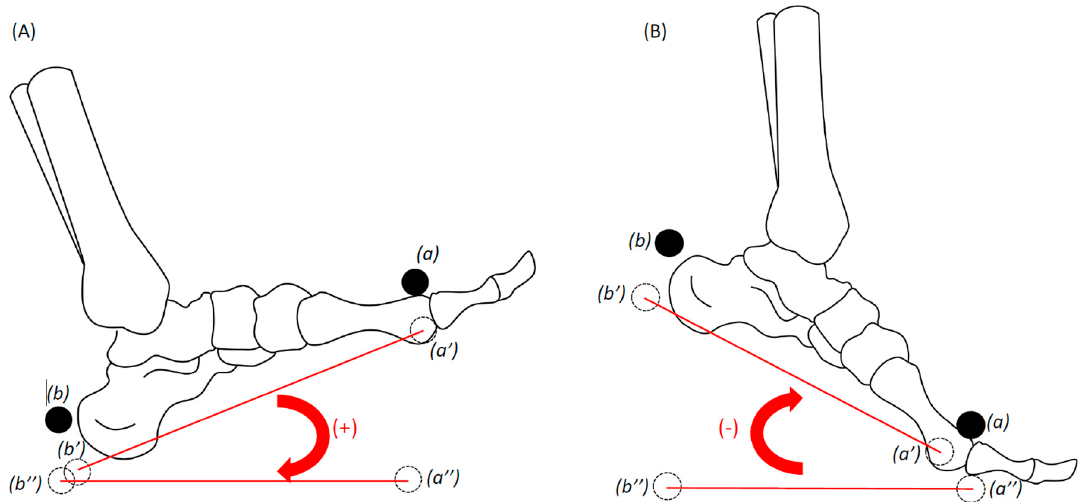
Figure 3. Foot angle is defined as the angle created by the bisection of a vector from the marker located on the first metatarsal head (a) projected on the foot sole (a’) to the marker located on the calcaneus posterior surface (b) projected on the foot sole (b’), with another vector from the marker located on the first metatarsal head (a) projected on the ground (a’’) to the marker located on the calcaneus posterior surface (b) projected on the ground (b’’) onto the sagittal plane of the foot. Positive foot angles were associated with the ( A ) rearfoot (RFS) pattern and negative foot angles with ( B ) forefoot pattern (FFS).